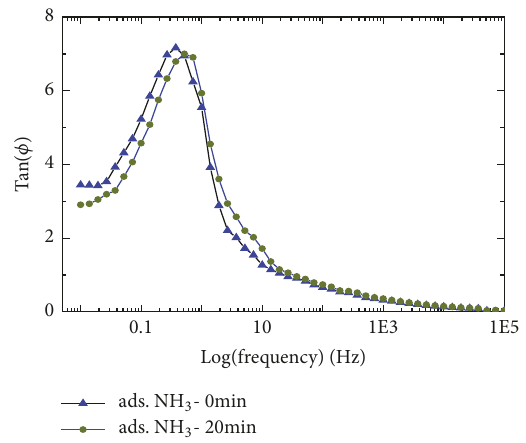
Figure 4: Loss tangent plot for ammonia adsorption on sulfated zirconia at 383